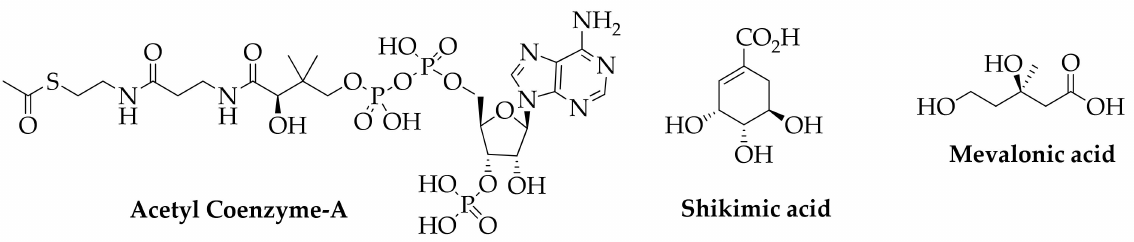
Figure 7. Building blocks for the biosynthesis of secondary metabolites.